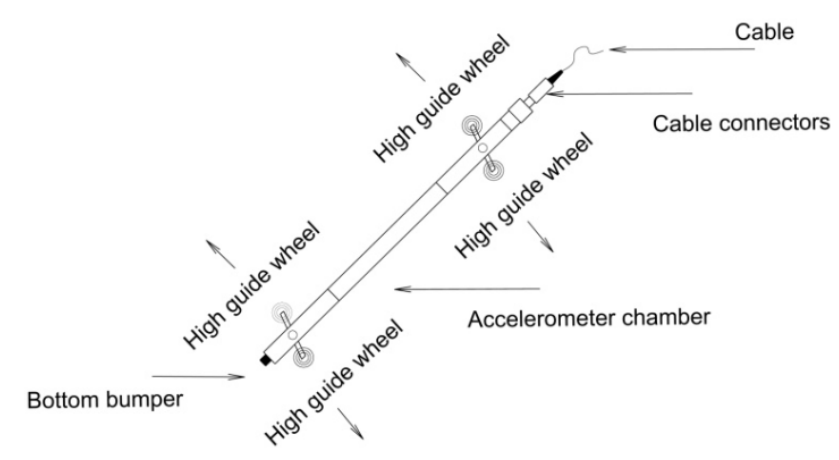
Figure 14. Oblique-gauge.